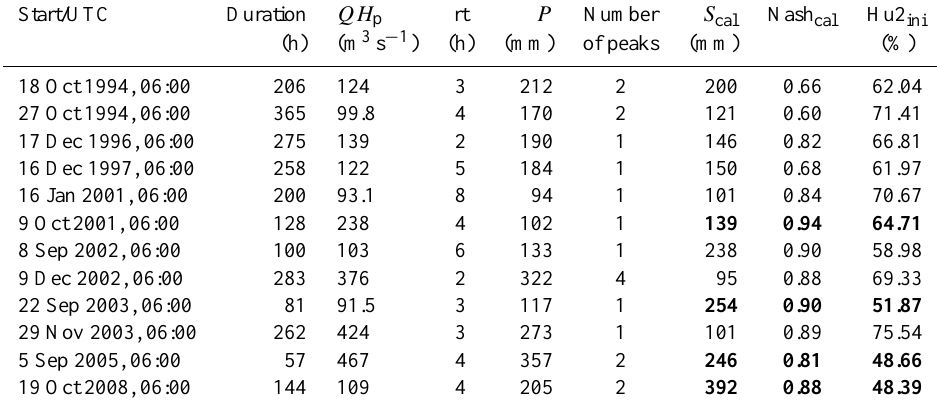
Table 1. Selected flood events – QH p : discharge peak with an hourly time step (m 3 s − 1 ); rt: response time (the delay between rainfall peak and discharge peak) (h); P : average cumulative rainfall (mm) calculated according to the Thiessen method; S cal : the value (mm) of the initial condition after calibration; Nash cal : the Nash value after calibration; Hu2 ini the value of the Hu2 index used to initialize the initial condition of the model. The values shown in bold correspond to simulations run with rainfall radar